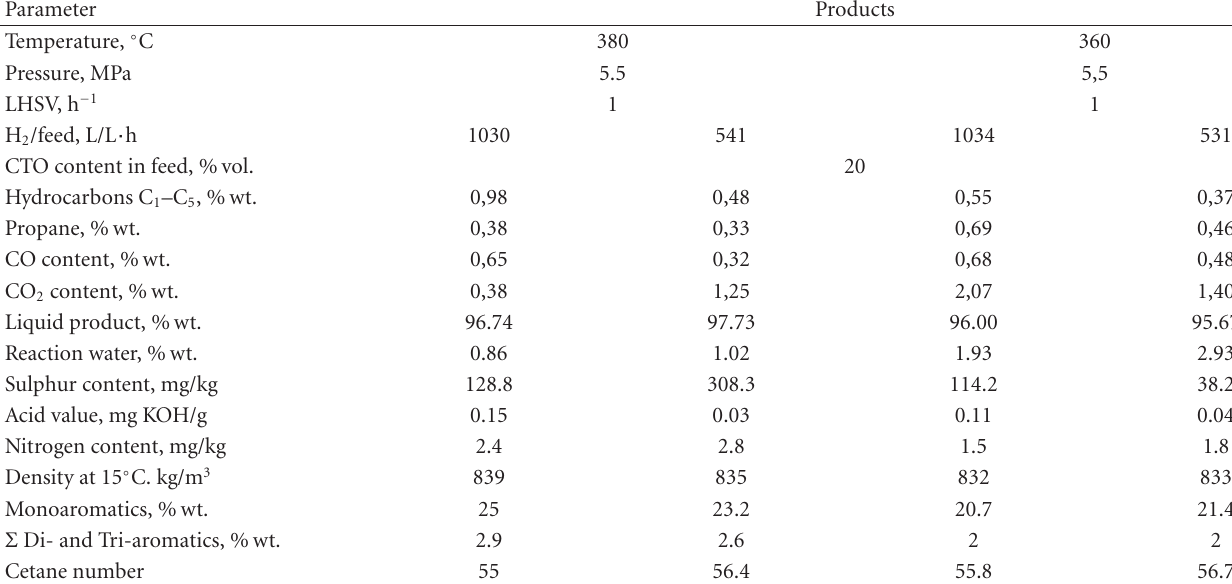
Table 5: Results of hydrorefining of the mixtures of gas oil and crude tall oil; catalyst B.